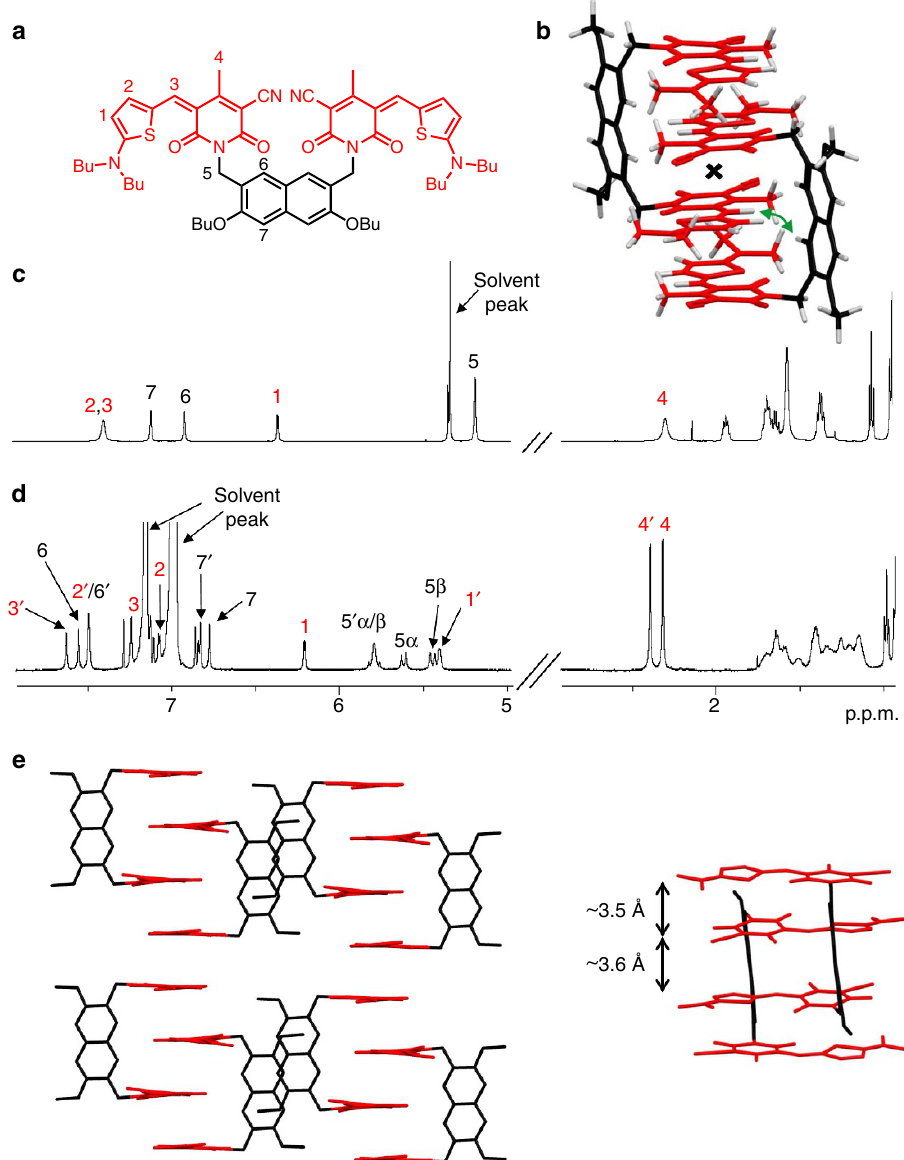
Figure 3 | NMR studies and single-crystal X-ray analysis of bis(merocyanine) 1. ( a ) Chemical structure of 1 with the significant protons numbered. ( b ) Geometry-optimized structure (B97D3/def2-SVP, butyl chains were replaced by methyl groups) of dimer aggregate. The inversion center of the dimer is indicated with a cross, and the green curved arrow indicates the close proximity of chromophore and backbone protons in the dimer. ( c ) Relevant sections of 1 H NMR (600MHz) spectrum of 1 monomer in CD 2 Cl 2 ( c ¼ 1 (cid:2) 10 (cid:3) 3 M) at 295K. ( d ) Spectrum of aggregate in C 6 D 5 Cl ( c ¼ 1 (cid:2) 10 (cid:3) 3 M) at 233K with the assignment of significant proton signals. The two sets of signals for the aggregate chromophore protons are denoted with and without prime of the respective signals. ( e ) Molecular packing of bis(merocyanine) 1 in the solid state (side view) with enlargement of the dimer structure motif (front view). Solvent molecules and hydrogen atoms are omitted for clarity and butyl chains were replaced by methyl